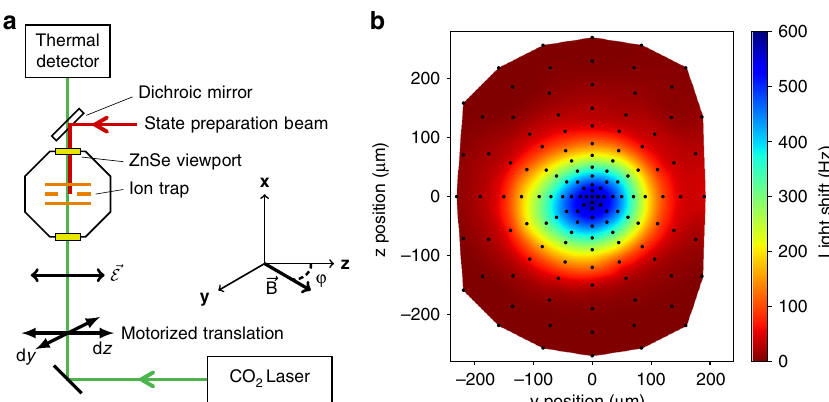
Fig. 2 Schematic of CO 2 laser setup and measured beam pro fi le. a The CO 2 laser is linearly polarized parallel to the z-axis. Motorized stages position the beam in the yz -plane (see Methods). The optical power is monitored after the vacuum chamber by a thermal detector. The magnetic fi eld is rotated in the yz -plane to form an angle ϕ with respect to the fi xed laser polarisation ~ E || z . A π -polarized 646 nm state preparation laser counter-propagates to the CO laser with the aid of a dichroic mirror. b Spatial pro fi le of the laser at the ion ’ s position measured via the light shift. Black points indicate measurement positions and the surface plot is a cubic spline interpolation of